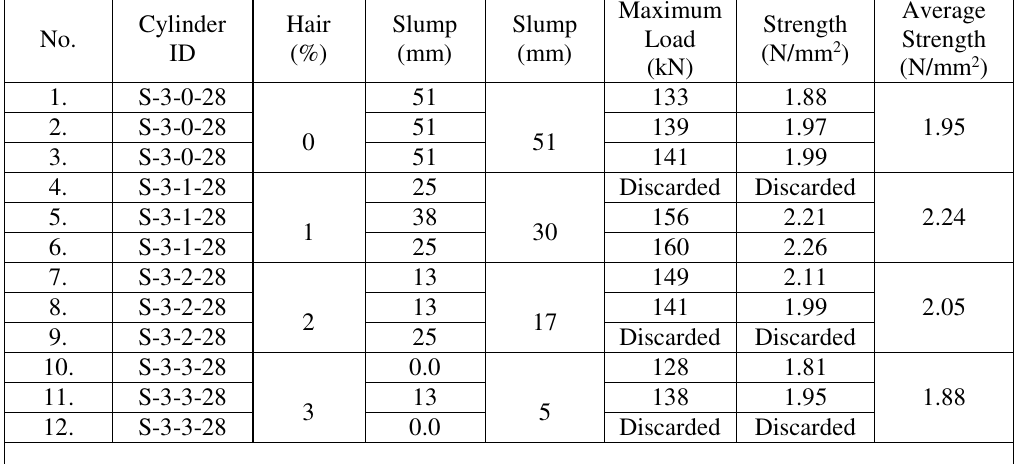
TABLE 3. SLUMP AND SPLITTING TENSILE STRENGTH TEST RESULTS AT 1:1.5:3